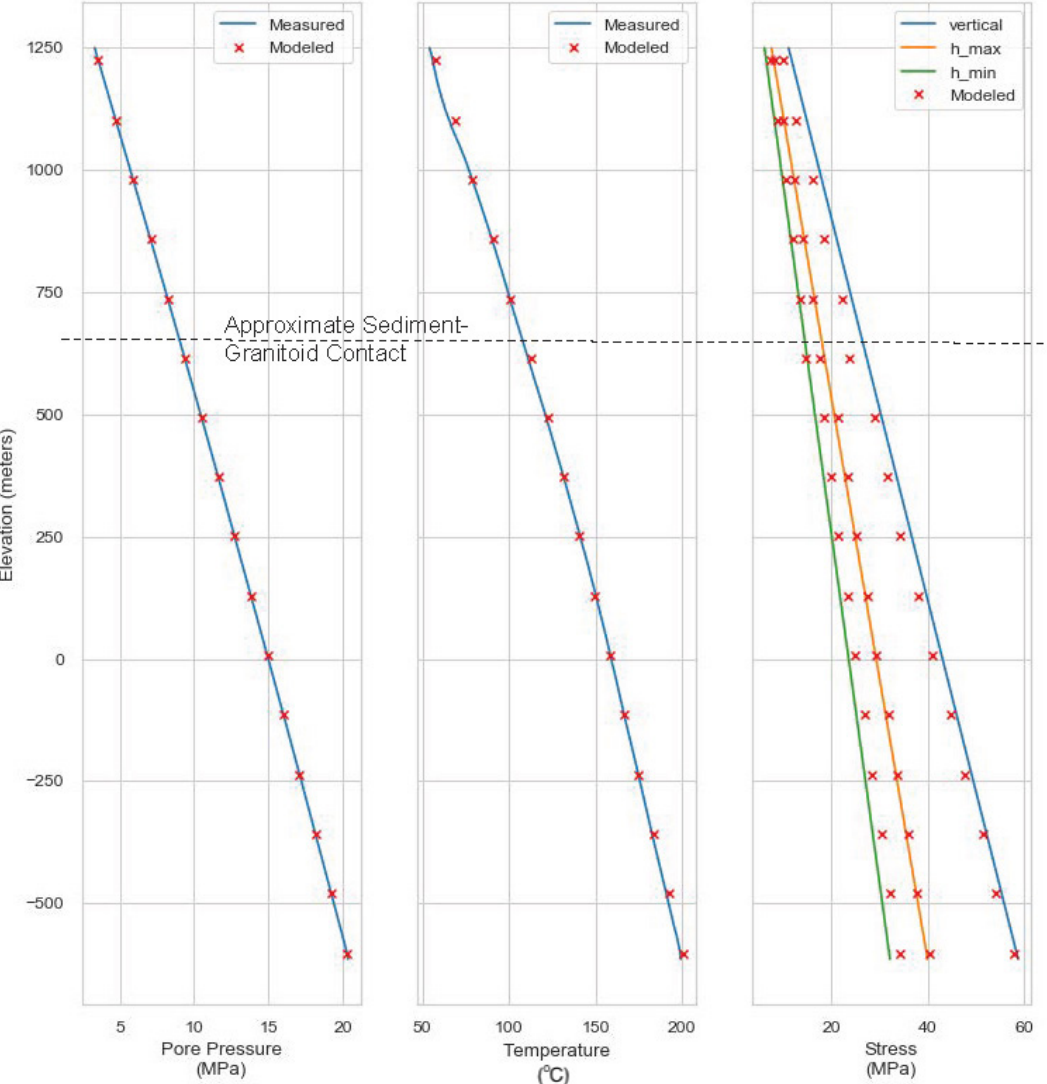
Figure 12. Native state model results compared with pressure-temperature log collected in November 2018. Stress plots are from estimates from Phase 2B testing in the open hole portion of Well 58-32. Note that the granitoid-sediment contact is at an approximate elevation of 720